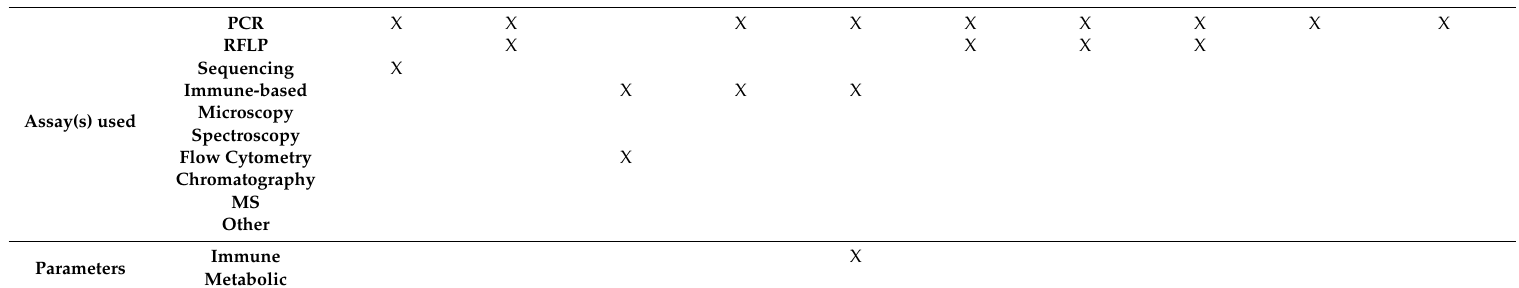
Table 1: The contrasting role of CCR5 in various diseases. ↑ increased; ↓ decreased; Mixed Cohort contains individuals from various ethnicities; a Homozygous genotype; b heterozygous genotype; Px patient group; S susceptibility; O disease onset; P disease progression; C clinical course / severity of disease; M mortality; A acute; Ch chronic; BC breast cancer; KO